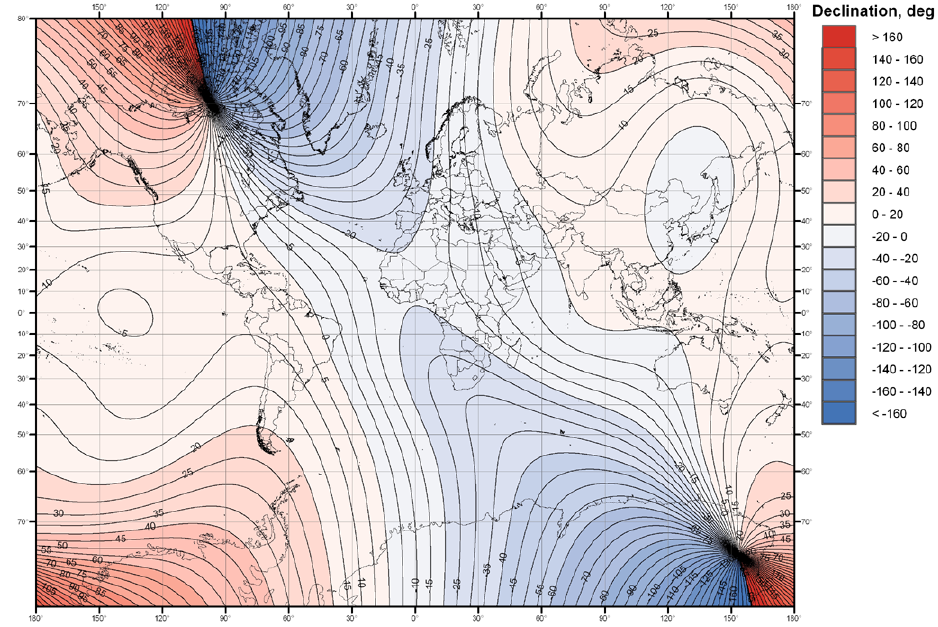
Figure 8. World map of isogons for 1830 calculated according to gufm1 model.